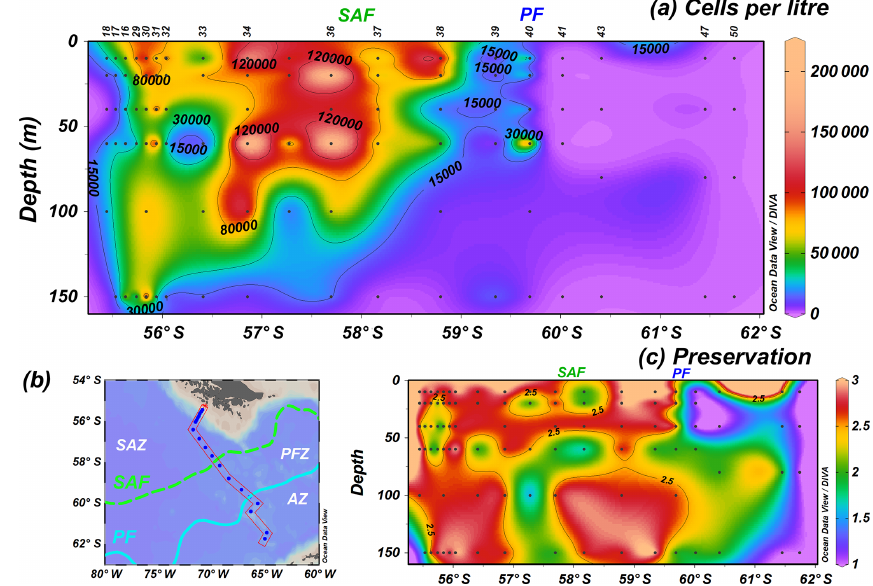
Figure 3. PS97 CTD stations showing (a) the number of coccospheres per litre across a (b) latitudinal transect in the Drake Passage and (c) semiquantitative estimates of coccolith preservation for the uppermost 150m of the water column (1 is poor, 2 is moderate and 3 is good). Black dots indicate sampling points, and the different oceanographic fronts according to Orsi et al. (1995) are indicated as SAF (green dashed line) and PF (blue